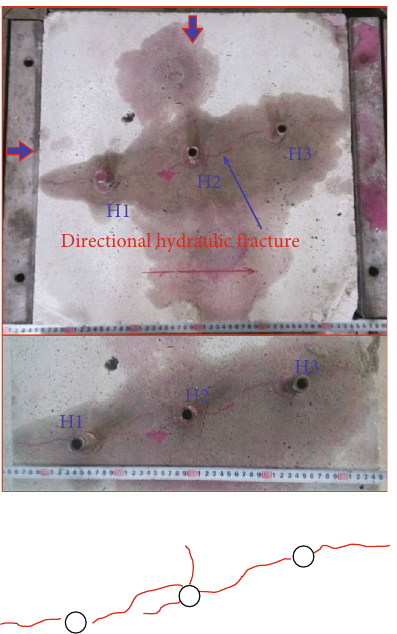
Figure 5: Propagation morphology of directional hydraulic fracturing [64].